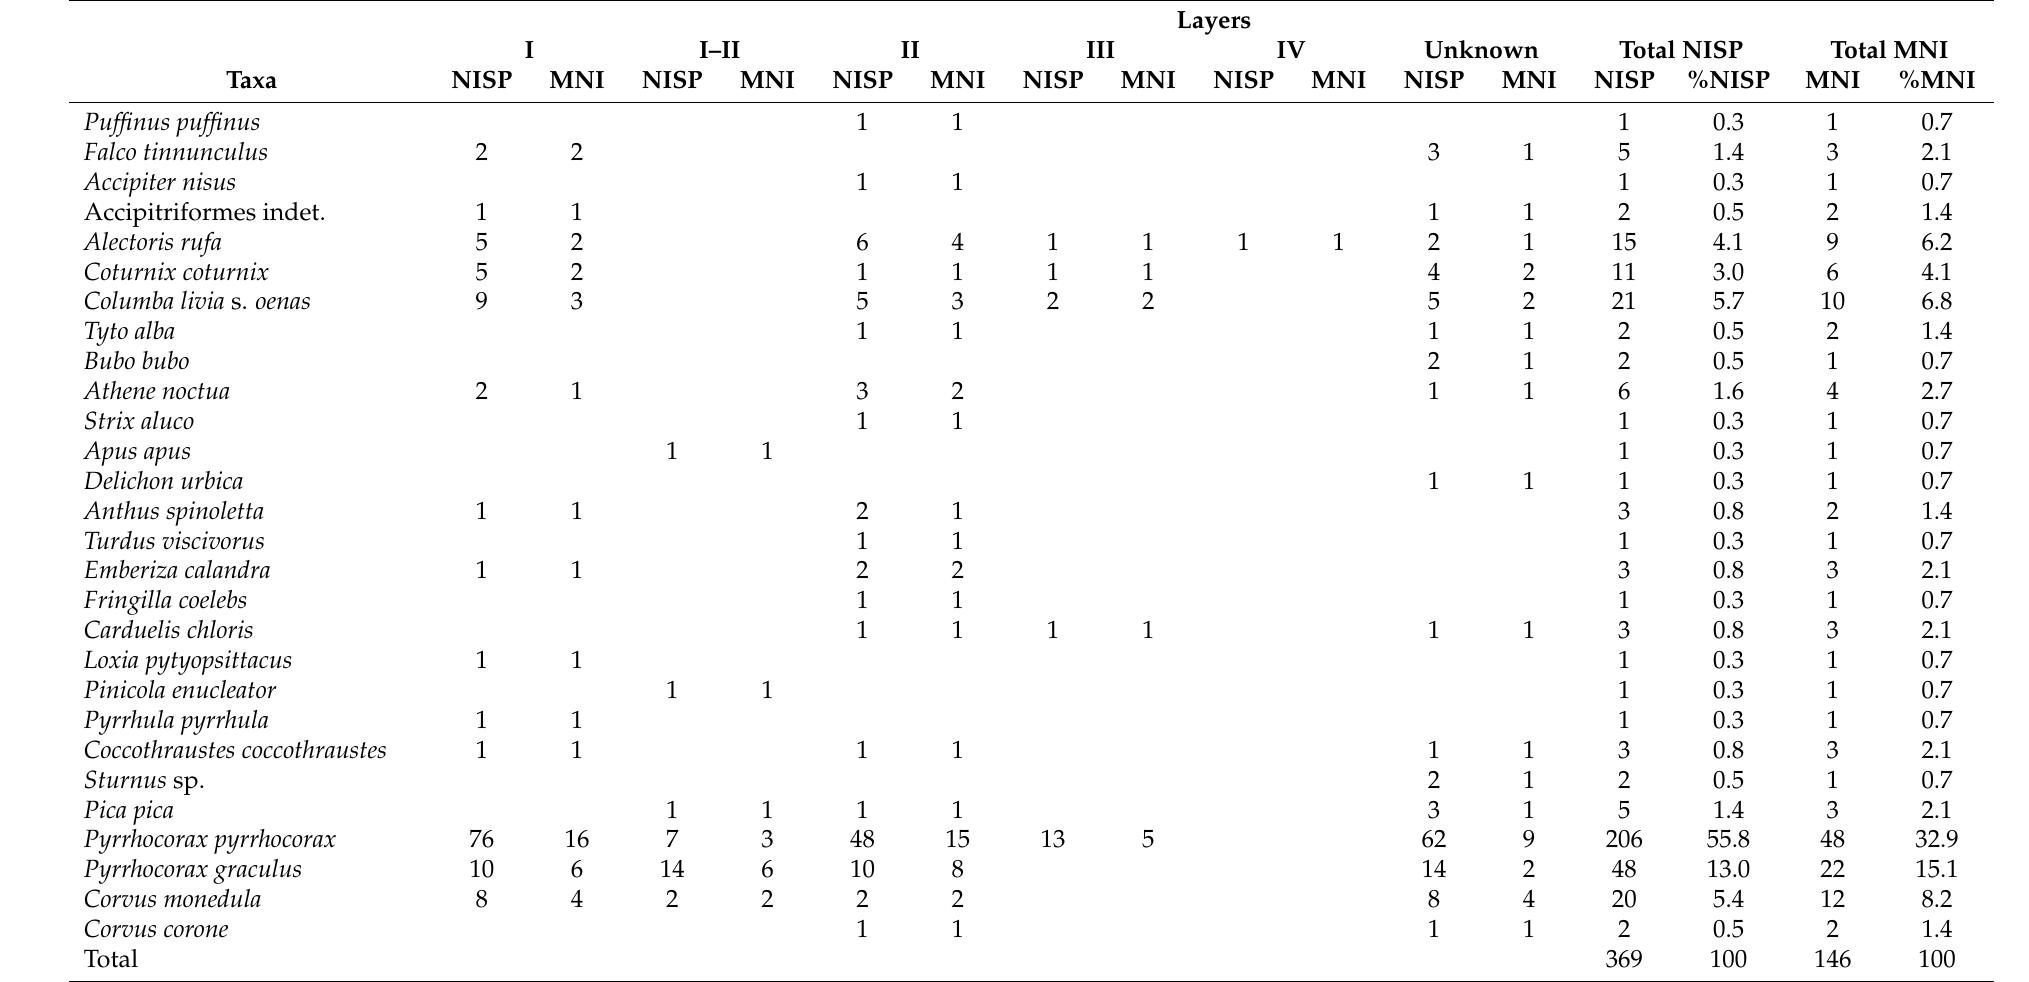
Table 4. Avian remains documented at